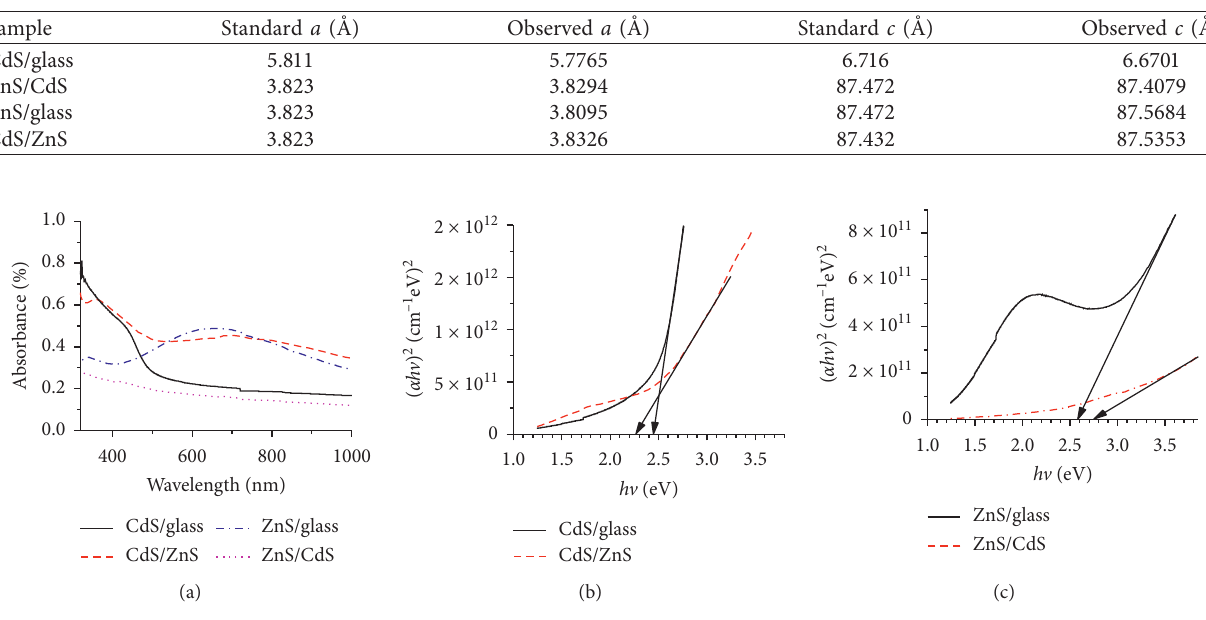
Figure 2: Optical absorbance and optical bandgaps of CdS/glass, CdS/ZnS, ZnS/glass, and ZnS/CdS thin